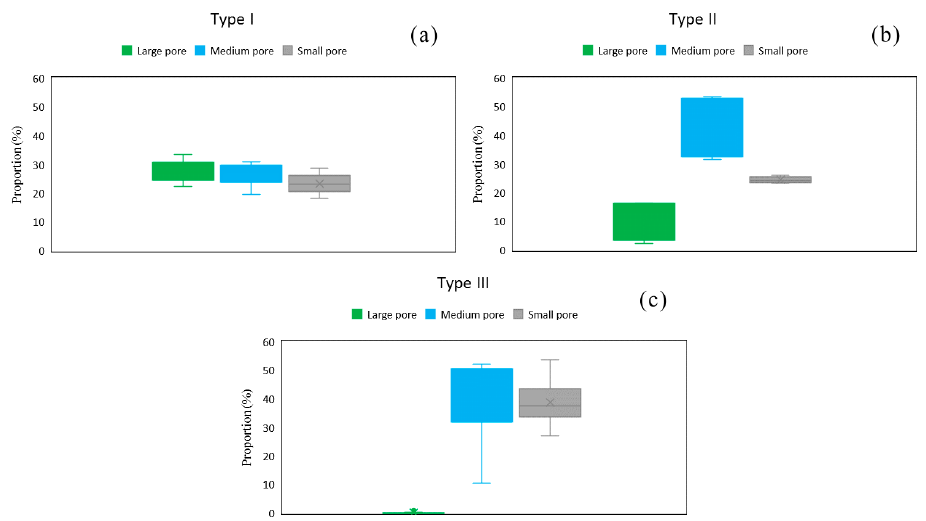
Figure 5. Different pore proportions of different reservoir types: ( a ) different pore proportion of Type I;